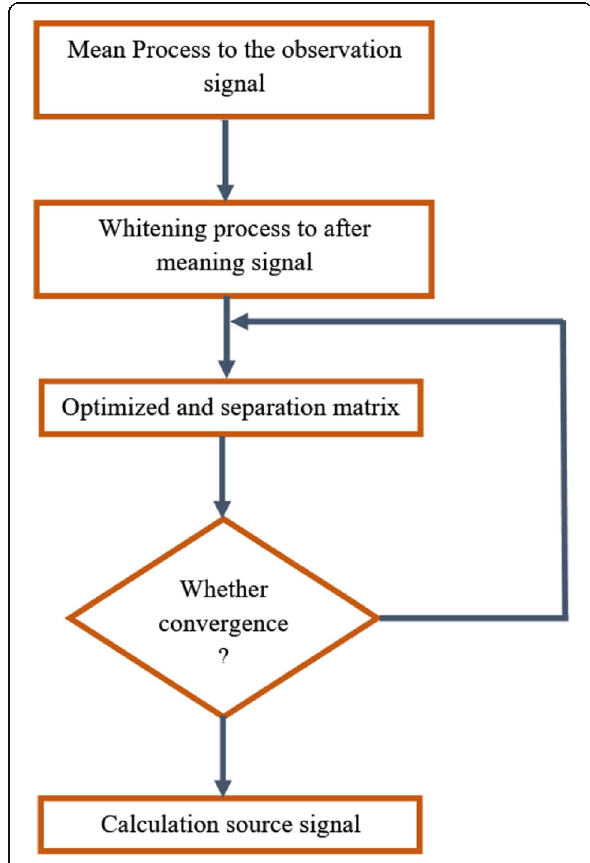
Fig. 7 Flowchart of the FastICA algorithm